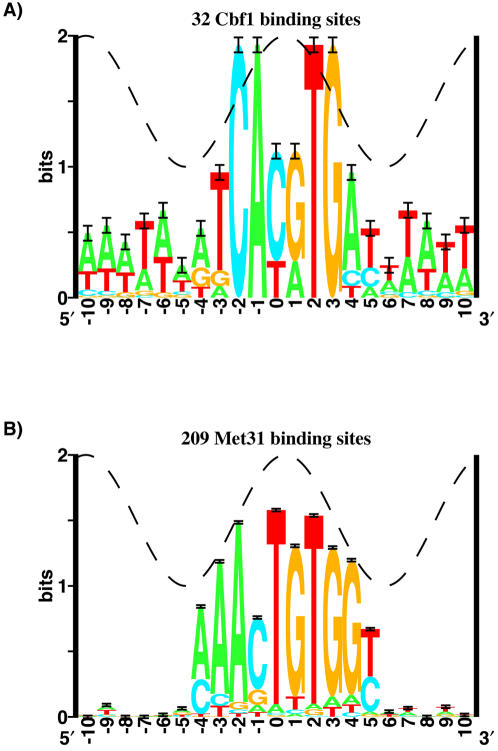
Cbf1 and Met31 sequence logos.Sequence logos were made as described in Materials and Methods. The height of each letter is proportional to the frequency of that base at that position. The height of the letter stack is the information content at that position. The cosine wave represents the helical twist of B-form DNA. The sequence logos were generated using the standard Delila programs [19], [21].